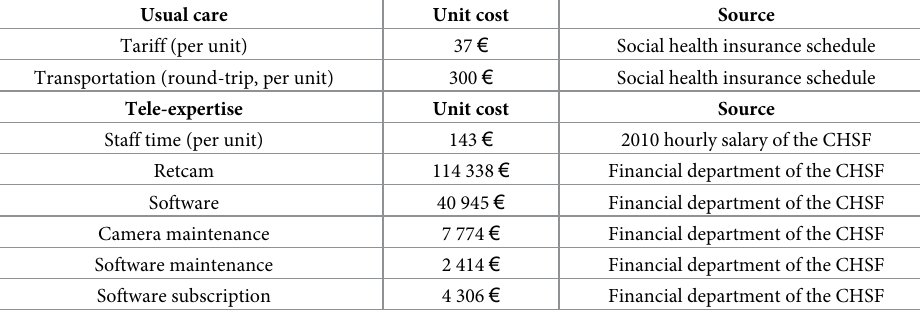
Table 1. Unit costs used for the economic